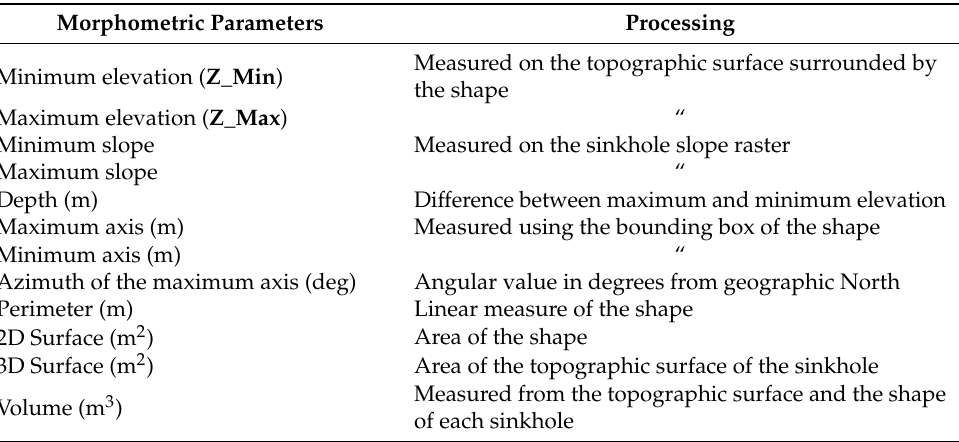
Table 1. List of the morphometric parameters generally used to characterize sinkholes, which can be automatically extracted from DEMs